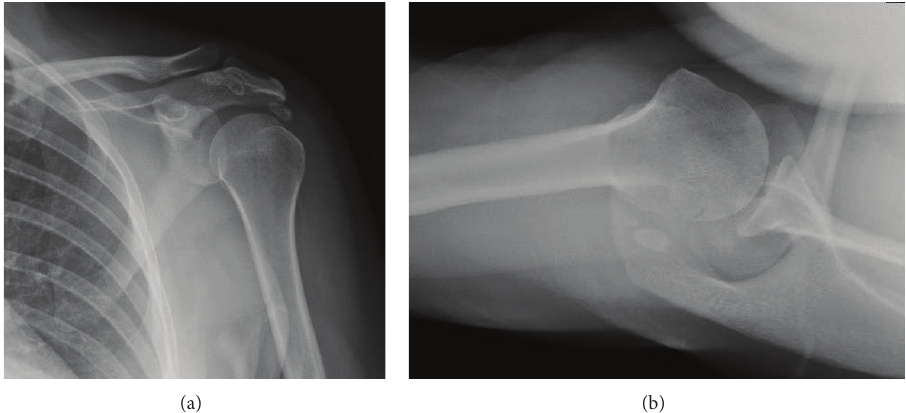
Figure 1: Preoperative (a) anteroposterior and (b) axillary lateral radiographs of the left shoulder showing periarticular calcified nodules and erosion of the AC joint.